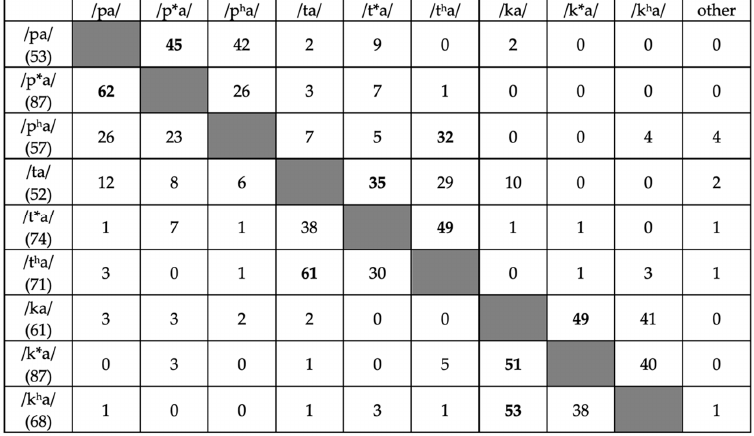
( b ) Figure 6. Individual posttest accuracy in the stop study by pretest performance, with regression lines ( a ) over all L1 groups together, and ( b ) over each L1 group separately. Points are jittered; the shaded areas indicate the 95% confidence interval around the regression line. 3.3. Study 2: Vowel Perception